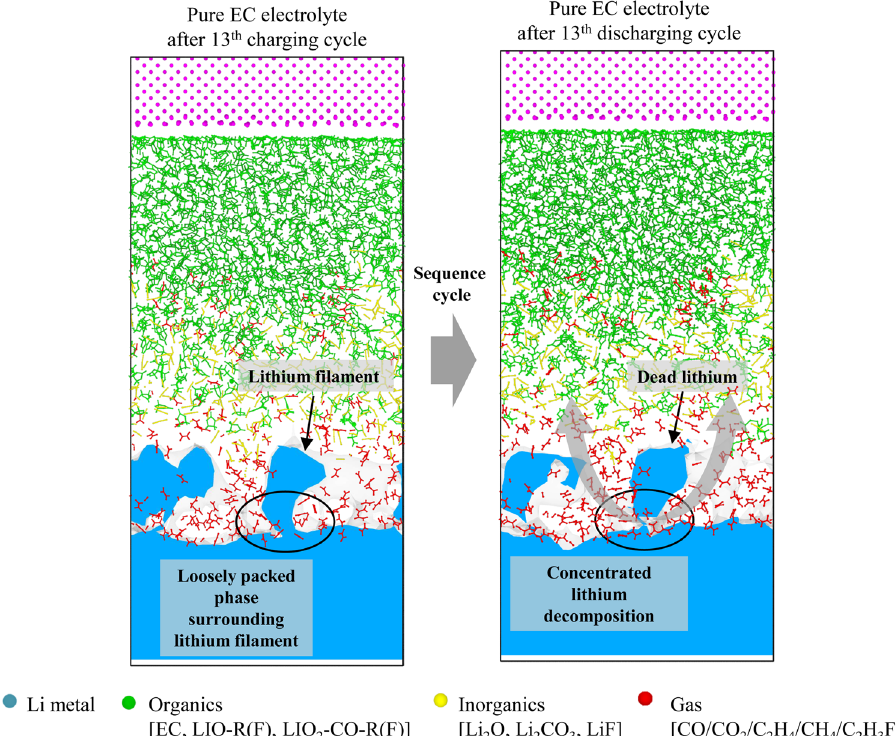
Fig. 6 Dead lithium formation during 13 th cycle by locally concentrated lithium dissolution around the bottom part of the lithium fi lament. The left-hand panel shows the loosely packed phase surrounding the lithium fi lament during the charging cycle. The right-hand panel shows dead lithium formation during the discharging